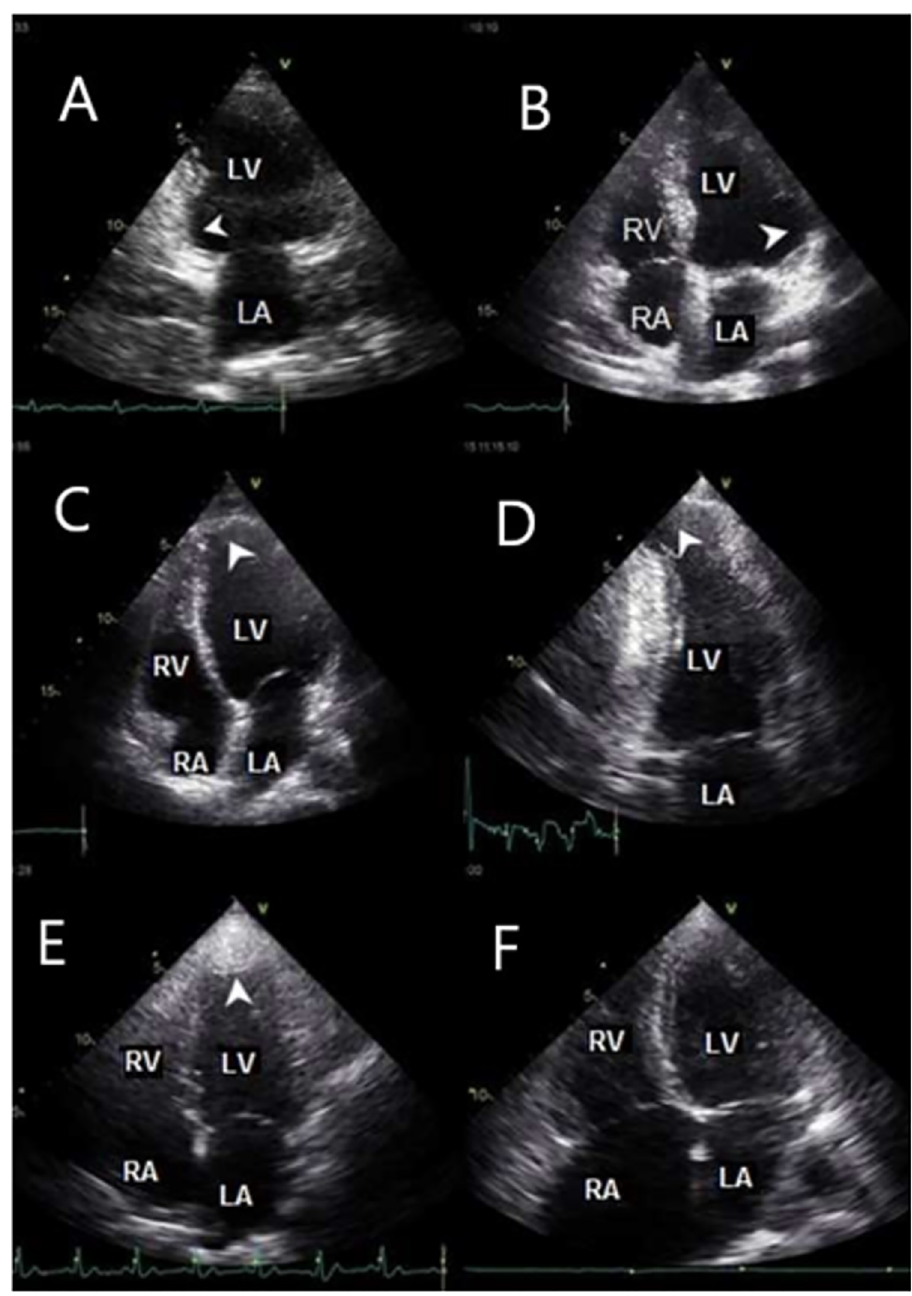
Fig 2. Echocardiographic studies of Chagas disease patients. A: akinesia of inferior wall, basal segment; B: akinesia of lateral basal wall, basal segment; C and D: LV apical aneurysm; E: LV apical thrombus; F: right-sided chambers dilation. LA: left atrium; RA: right atrium; LV: left ventricle; RV: right ventricle. In the overall patient population, 103 patients (14%) presented with LV systolic dysfunc- tion. The echocardiographic parameters are summarized in Table 2. Patients who had normal or minor ECG abnormalities, LV ejection fraction was within the normal limits, whereas those who presented major ECG changes, including frequent ventricular and ectopic beats, atrial